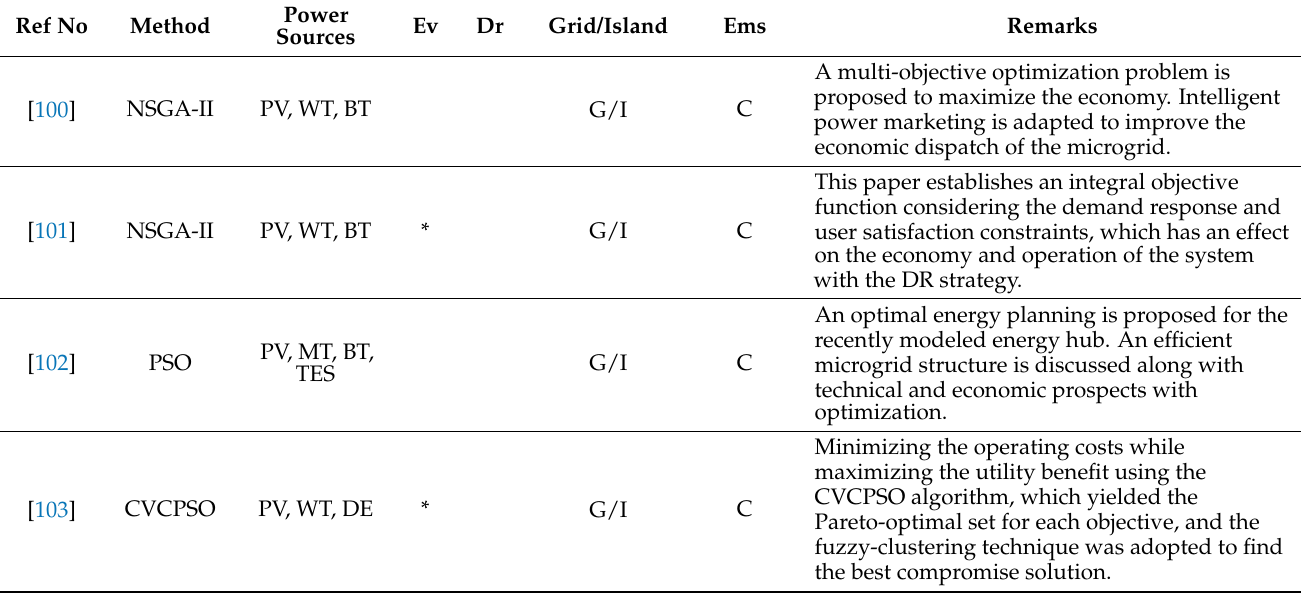
Table 6. A review of metaheuristic methods used in